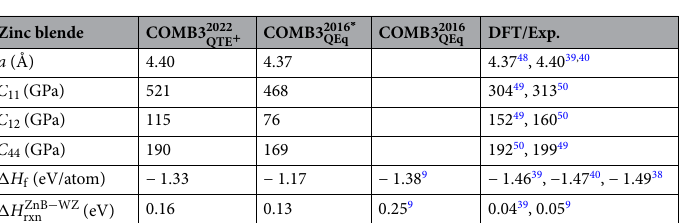
and COMB3 2016 ∗ QEq are compared to the QTE +